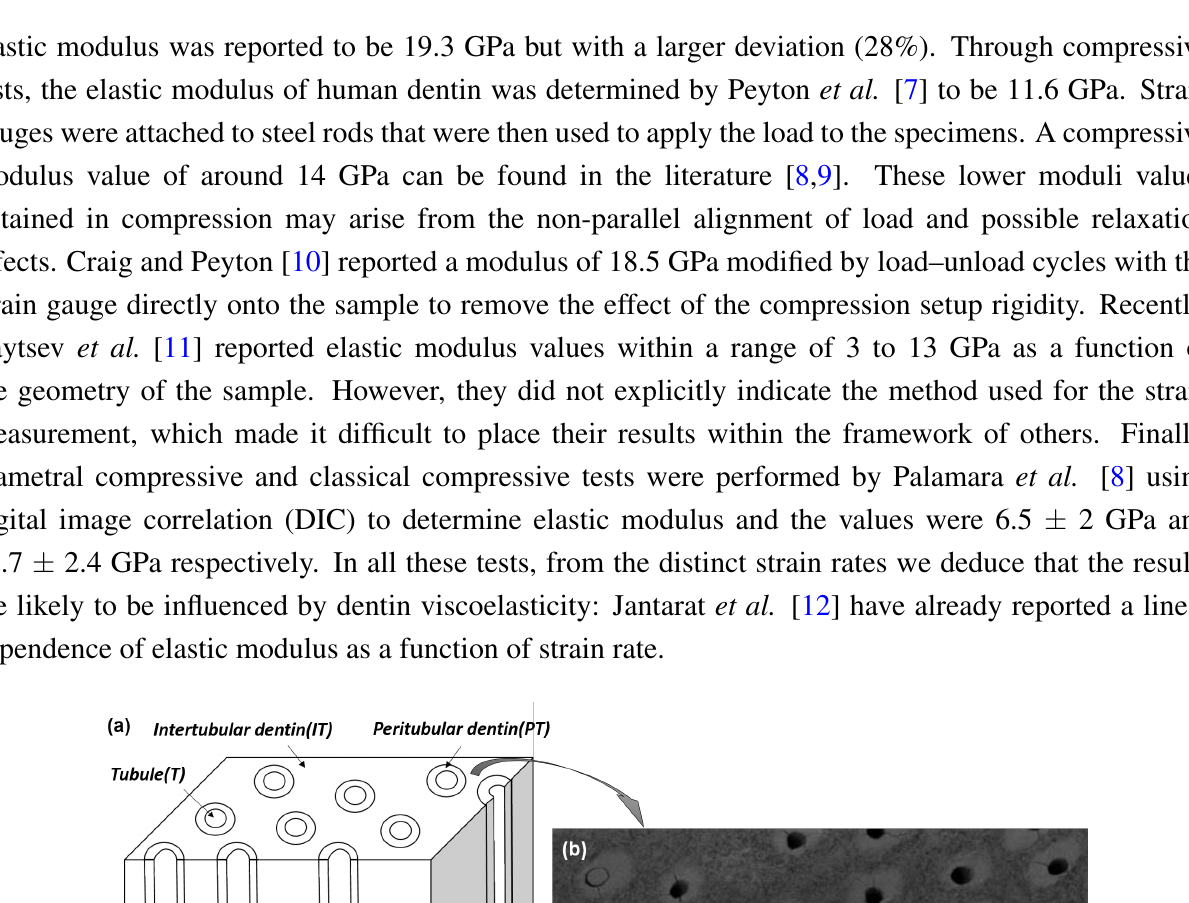
) and transverse l